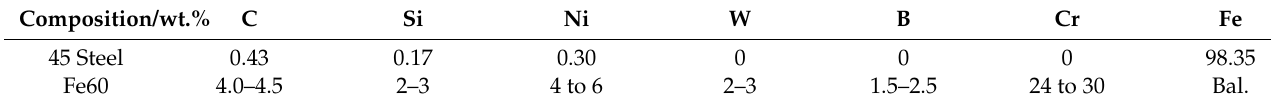
Table 1. The element content of 45 steel and Fe60 powder.